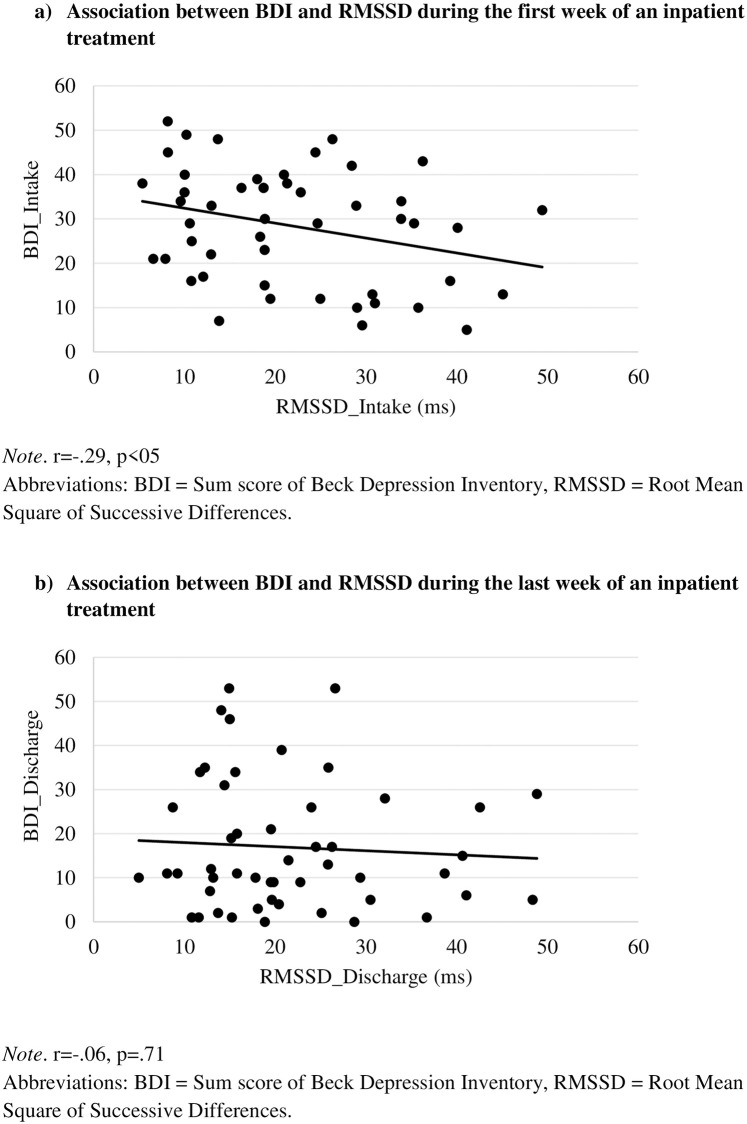
a) Association between BDI-II and RMSSD during the first week of an inpatient treatment. r = -.29, p<05. b) Association between BDI-II and RMSSD during the last week of an inpatient treatment. r = -.06, p = .71. Abbreviations: BDI-II = Sum score of Beck Depression Inventory, RMSSD = Root Mean Square of Successive Differences.